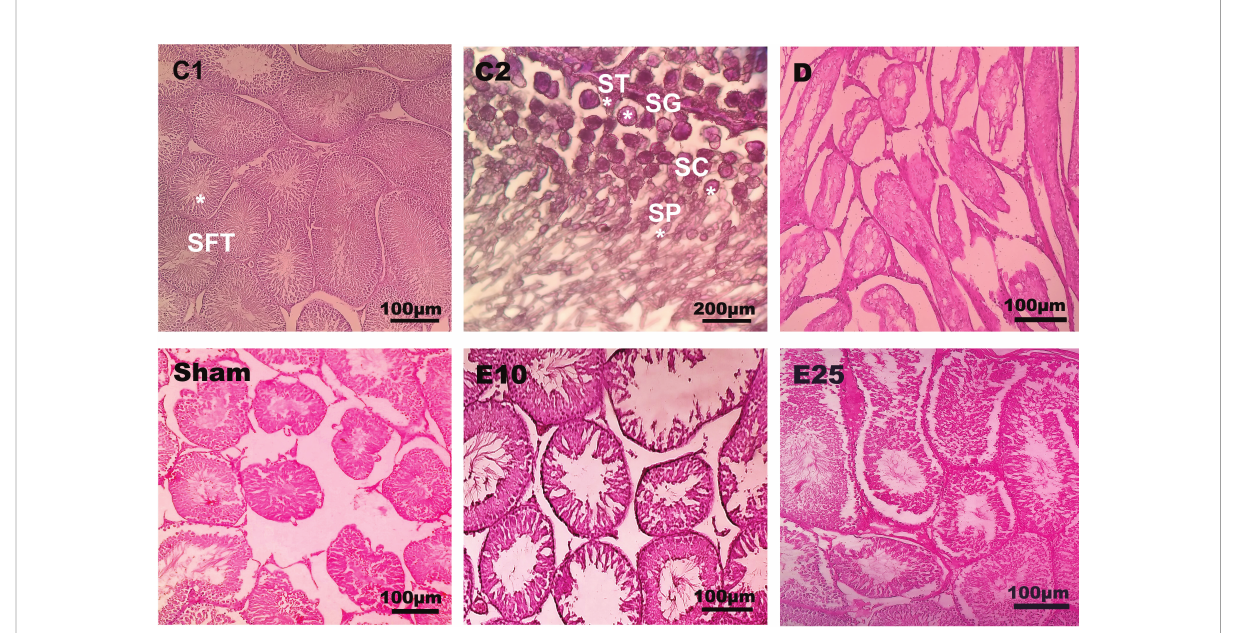
FIGURE 2 Testis cross-section. C1: control rats (magni fi cation x400), C2: control rats (magni fi cation x1000), D: diabetes group, sham: diabetic rats that received distilled water for 8 weeks, E10: empagli fl ozin-10 group (diabetic rats that received 10 mg/kg/day empagli fl ozin for 8 weeks, E25: empagli fl ozin-25 group (diabetic rats that received 25 mg/kg/day empagli fl ozin for 8 weeks. SFT: seminiferous tubules, SG: spermatogonia, ST: Sertoli cells, SC: spermatocyte, SP: spermatid. Magni fi cation of D, sham, E10, and E25: x400.